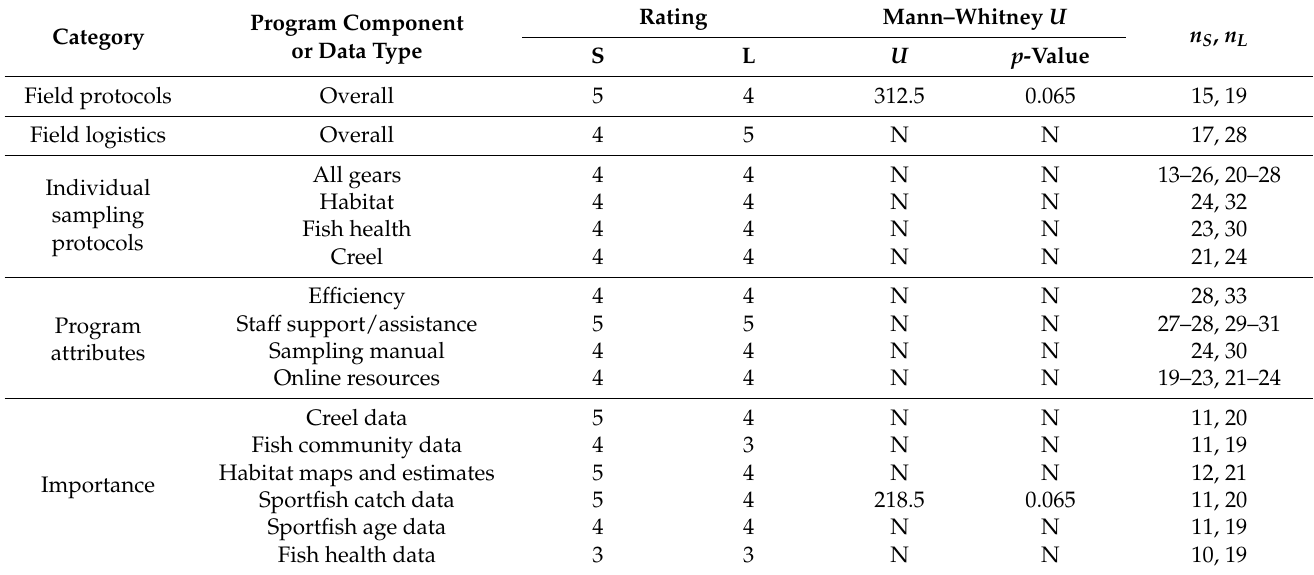
Table 5. Ratings of Florida’s statewide Freshwater Fisheries Long-Term Monitoring (LTM) program by short-tenured (S, ≤ 5 years) and long-tenured (L, >5 years) personnel. Ratings encompass LTM program components (ranging from 1 [very poor] to 5 [very good]) and the importance of different data types (ranging from 1 [not at all important] to 5 [extremely important]). The table includes results of Mann–Whitney U tests comparing median ratings of S and L personnel; N denotes little to no evidence of differences, and n S and n L denote the number of S and L respondents, respectively.